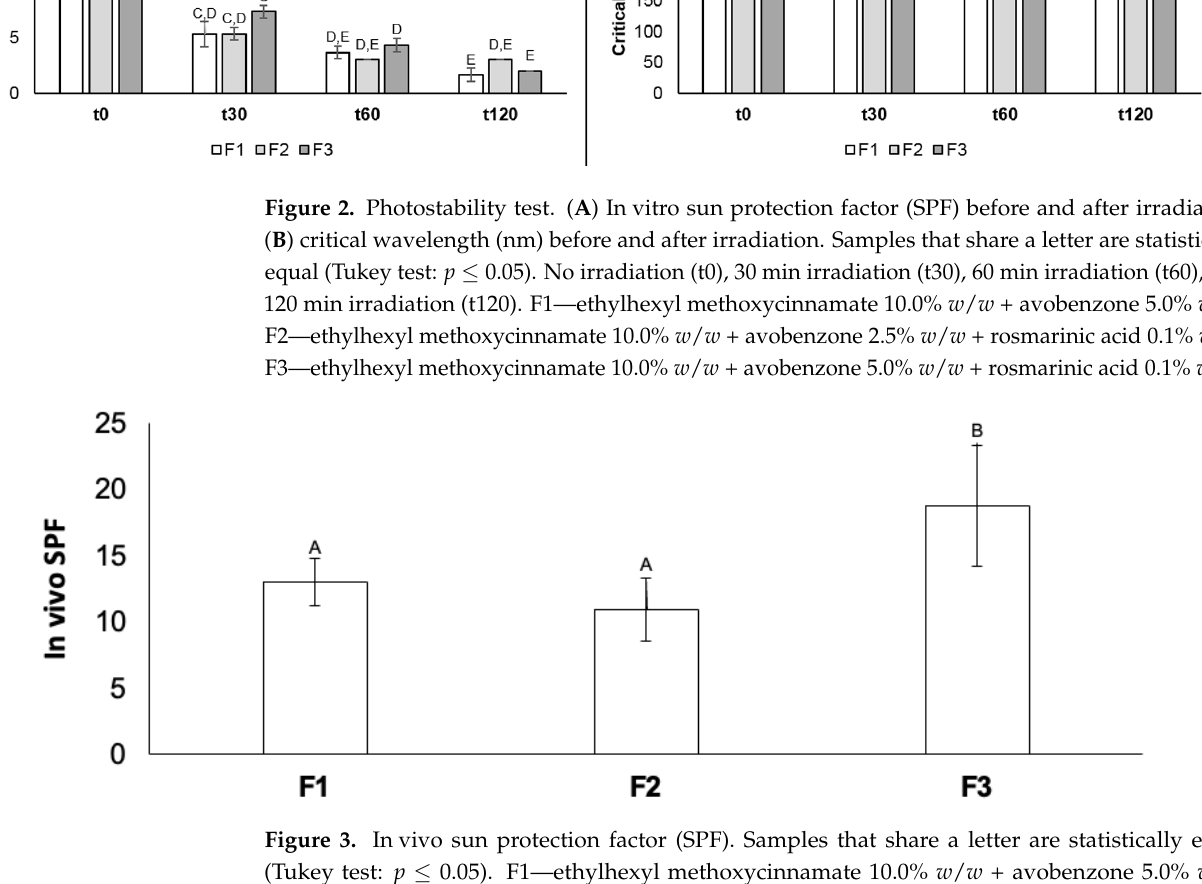
Figure 3. In vivo sun protection factor (SPF). Samples that share a letter are statistically equal (Tukey test: p ≤ 0.05). F1 — ethylhexyl methoxycinnamate 10.0% w / w + avobenzone 5.0% w / w ; F2 — ethylhexyl methoxycinnamate 10.0% w / w + avobenzone 2.5% w / w + rosmarinic acid 0.1% w / w ; F3 — ethylhexyl methoxycinnamate 10.0% w / w + avobenzone 5.0% w / w + rosmarinic acid 0.1% w / w .